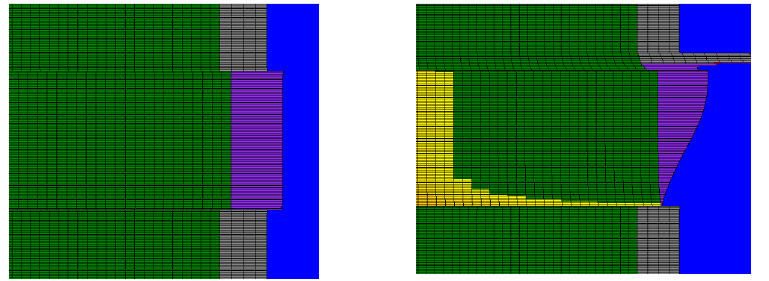
Fig. 3. The distribution of materials for different time moments. Left – 1,56 s. Right – 2,9 s. Green – uranium dioxide in solid state. Yellow – melt of uranium dioxide. Purple – melt of stainless steel. Grey – stainless steel in solid